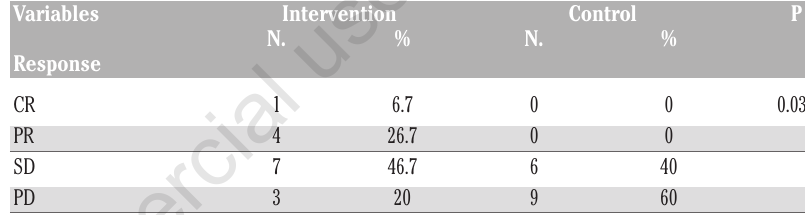
Table 3. Response status in intervention and historical control groups.